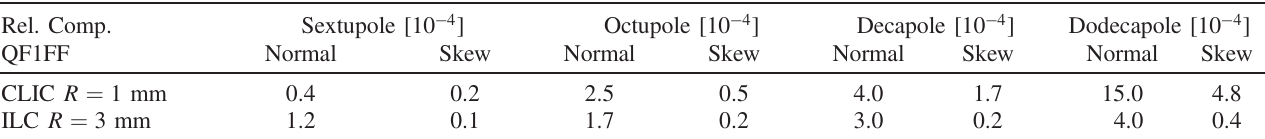
TABLE VI. Comparison between the relative multipole components (Rel. Comp.) tolerances of QF1FF magnet at R ¼ 1 mm for CLIC and R ¼ 3 mm for ILC. Each tolerance represents a luminosity loss of 2%. Rel. Comp.